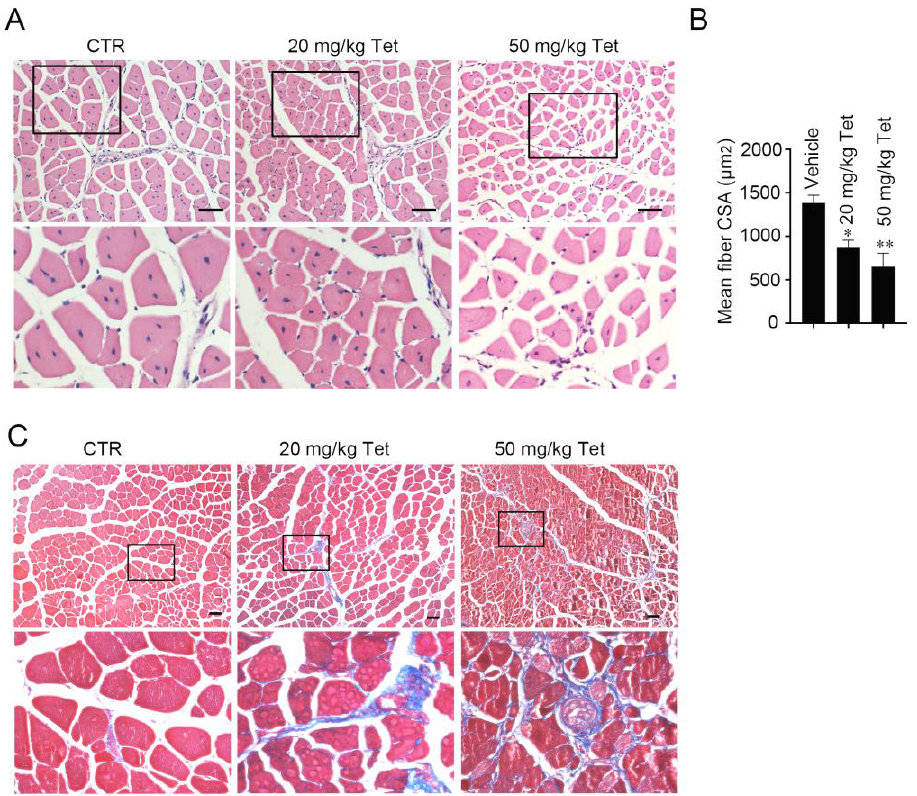
Figure 2. Tetrandrine inhibits skeletal muscle regeneration. Injury was induced in the left TA mus- cles of mice by intramuscular injection of BaCl2, and the mice were randomly distributed into three groups (five mice per group): vehicle and tetrandrine (20 and 50 mg·kg −1 body weight) P.O. every other day for 28 days. ( A ): H/E-stained cross-sections of the regenerated TA muscles. ( B ): The aver- age cross-sectional area (CSA) (mean ± S.D.) of the muscle fibers in A was quantified. n = 5, * p < 0.05 and ** p < 0.01. ( C ): Masson’s trichrome-stained cross-sections of regenerated TA muscles and the fibrotic regions are shown (blue color). Scale bars: 50 μm. CTR, control mice; Tet, tetrandrine; CSA, cross-sectional area.